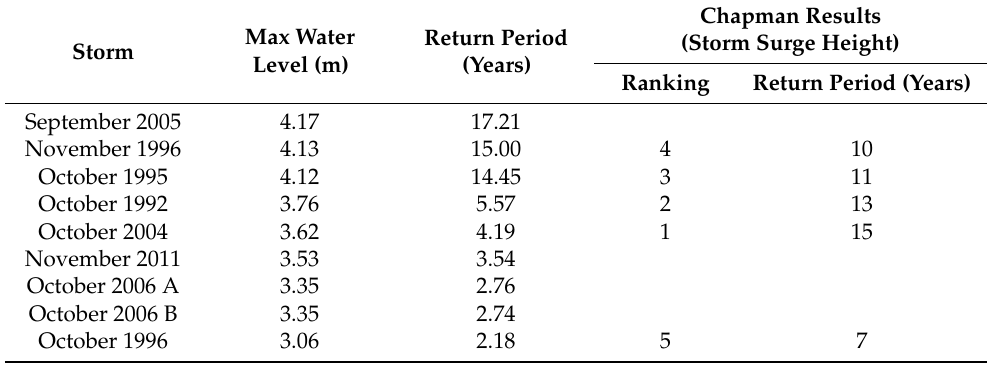
Table 6. Storm-return